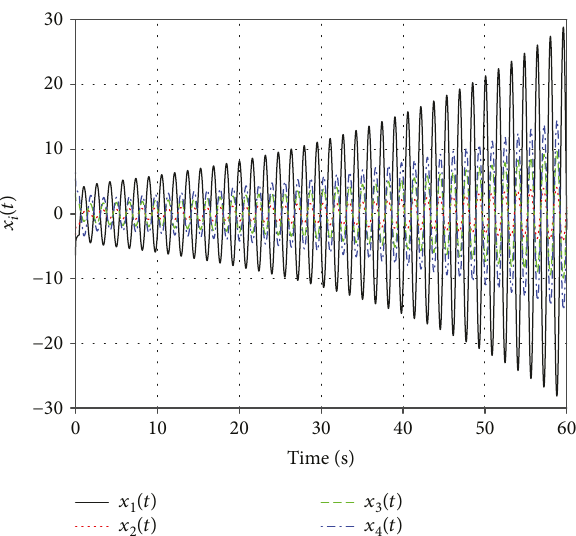
t applying the protocol in (6) under i . 1